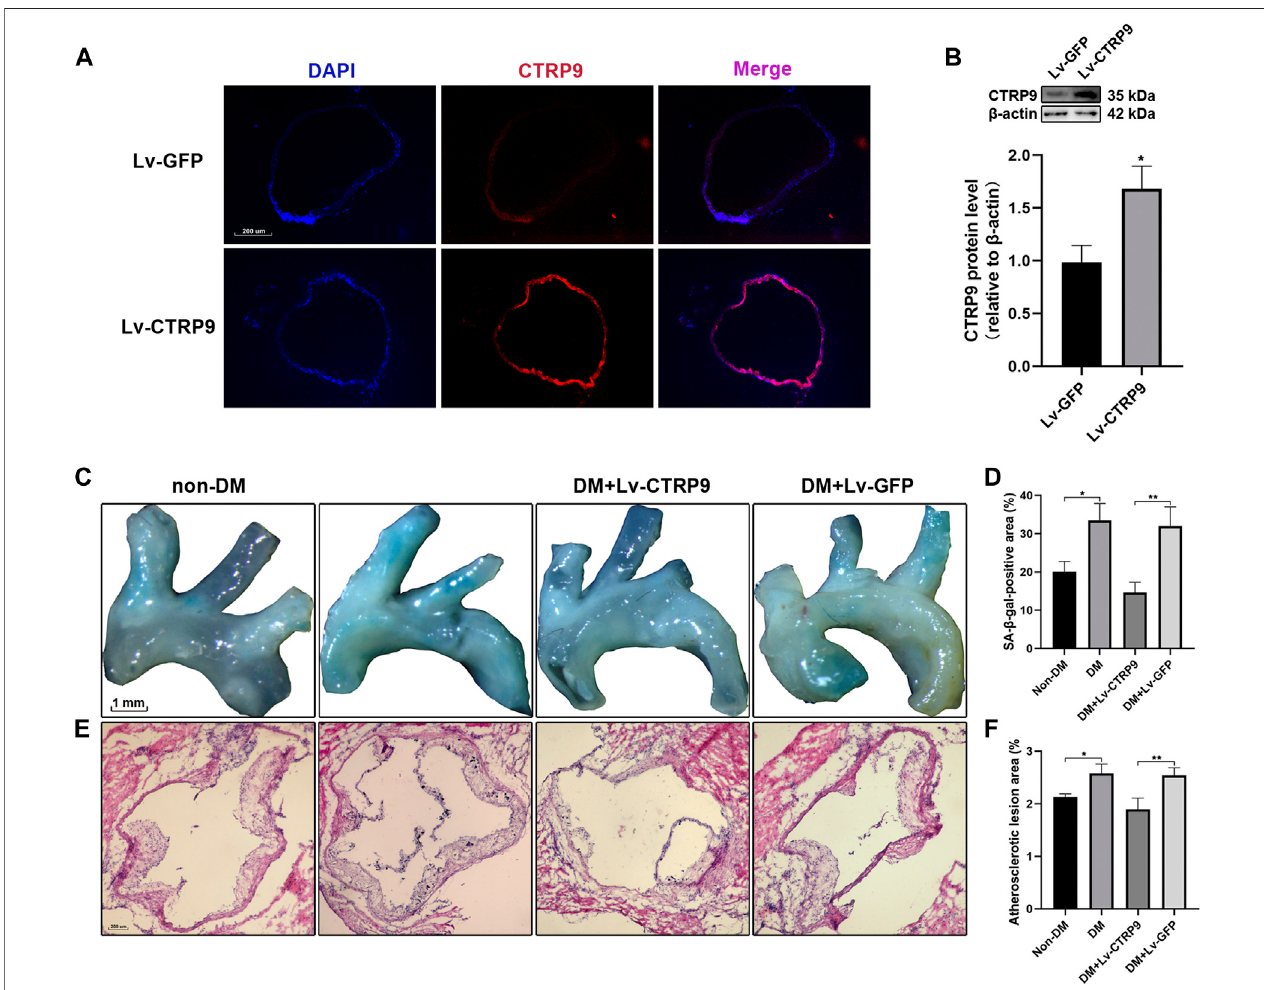
FIGURE7| OverexpressionofCTRP9inhibitsvascularsenescenceandreducesatheroscleroticplaqueformationinSTZ-inducedApoEKOmice. (A) Transfection ef fi ciency of CTRP9 lentivirus in aortic roots was measured by immuno fl uorescence staining. The images were taken at × 100magni fi cation and sections were stained with CTRP9 (red) and DAPI (blue). A representative image from three separate experiments is illustrated. (B) Expression of CTRP9 protein levels in aortic tissue was detectedbyimmunoblotting.Resultswerenormalizedtocontrols,andhistogramsrepresenttherelativeintensityofCTRP9.Valuesrepresentmean ± SEM( n (cid:2) 3 – 4 per group). * p < 0.05, signi fi cantly different from the Lv-GFP group. (C) The aortas were stained with SA- β -gal to analyse vascular senescence degree. (E) The aortas rootswerestainedwithH&Etoestimatethesizeofatherosclerosislesions. (D,F) Quantitativeanalysisoflesionareas inaortasand aorticroots.Valuesrepresent mean ± SEM ( n (cid:2) 3 – 4 per group). *p < 0.05, **p <